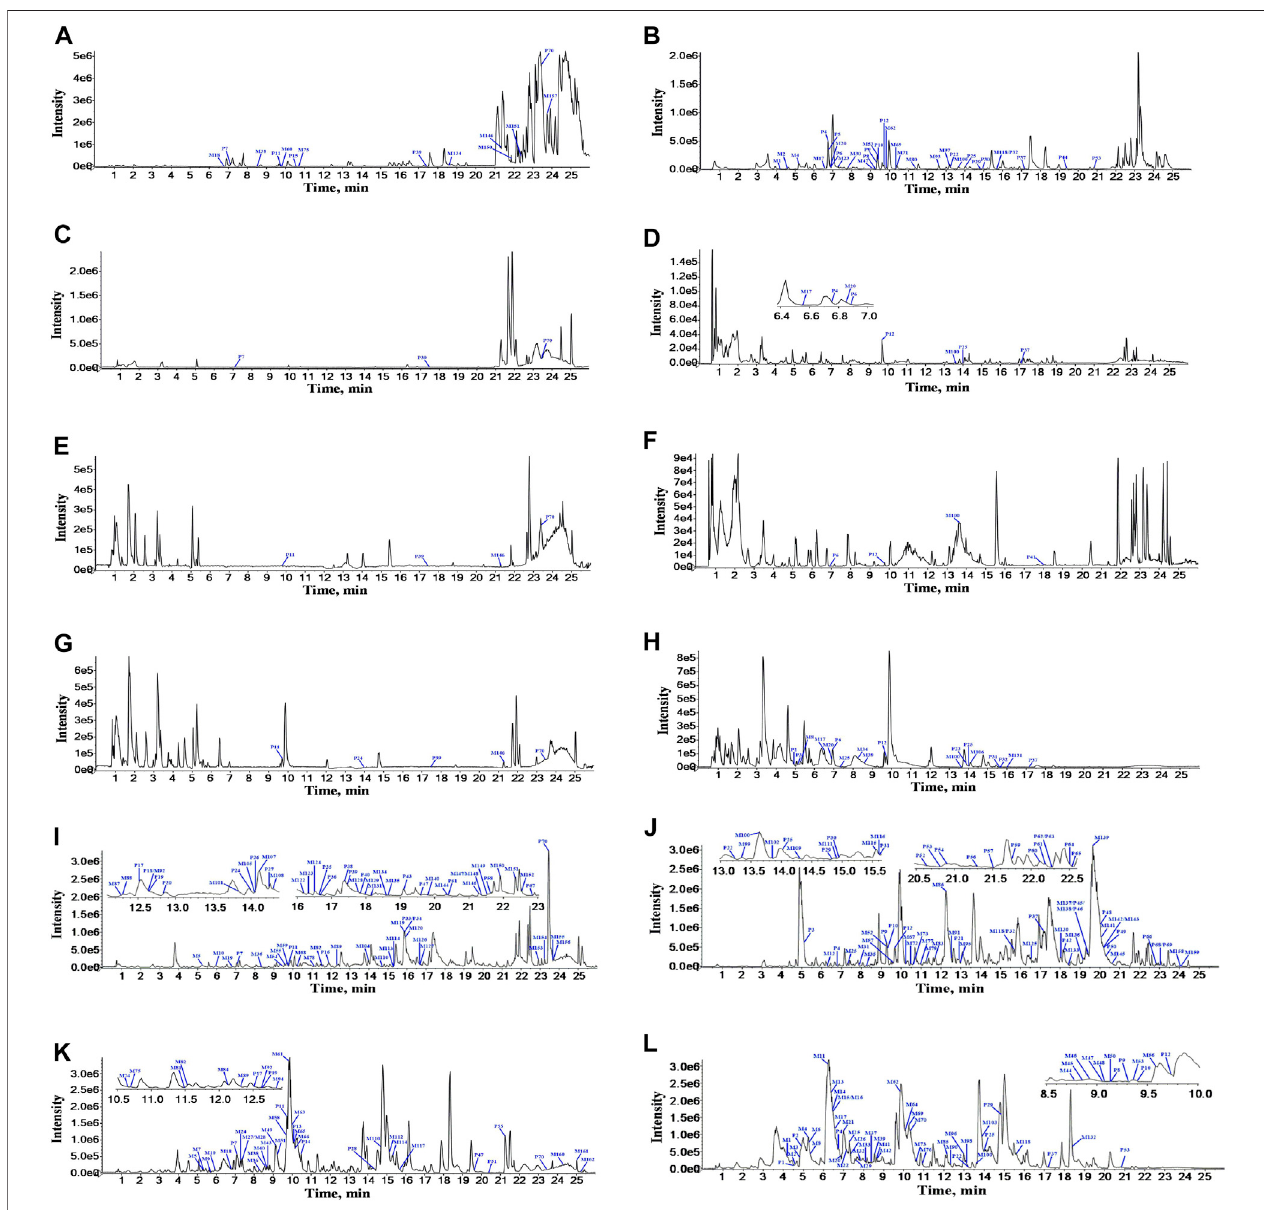
FIGURE2| TheBPCsofprototypesandmetabolitesafteroraladministrationofZGCinpositiveandnegativeionmodes. (A) seruminpositiveionmode. (B) serum in negative ionmode. (C) heartinpositiveionmode. (D) heart innegativeion mode. (E) liver inpositive ionmode. (F) liverinnegativeionmode. (G) kidneysinpositiveion mode. (H) kidneys in negative ion mode. ( Ⅰ ) feces in positive ion mode. (J) feces in negative ion mode. (K) urine in positive ion mode. (L) urine in negative ion mode.